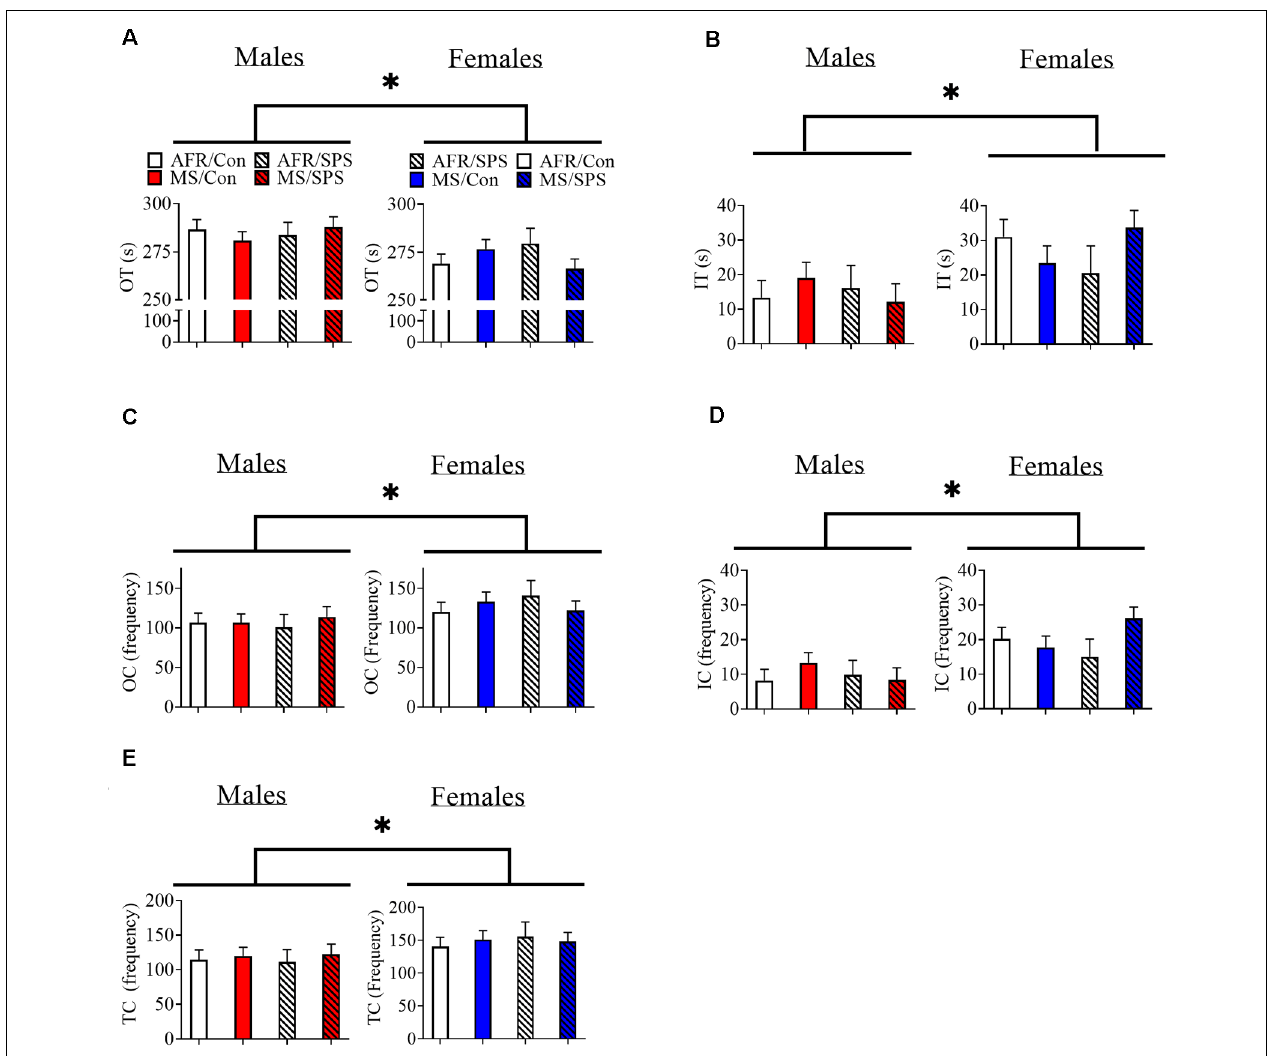
FIGURE 1 | The effects of MS and SPS on OF behavior. (A,B) Female rats (AFR/control = 10, AFR/SPS = 4, MS/control = 10, MS/SPS = 10) spent less time in the outer region (A) and more time in the inner region (B) of the OF arena than male rats (AFR/control = 10, AFR/SPS = 12, MS/control = 6, MS/SPS = 9). However, (C–E) female rats made more entries into the inner and outer regions of the OF arena. Neither MS nor SPS had any statistically significant effect on OF behavior. ∗ Statistical comparison that has a p < 0.05. OT, outer time; IT, inner time; OC, outer crossing; IC, inner crossing; TC, total crossing; MS, maternal separation; SPS, single prolonged stress; AFR, animal facility rearing; OF, open